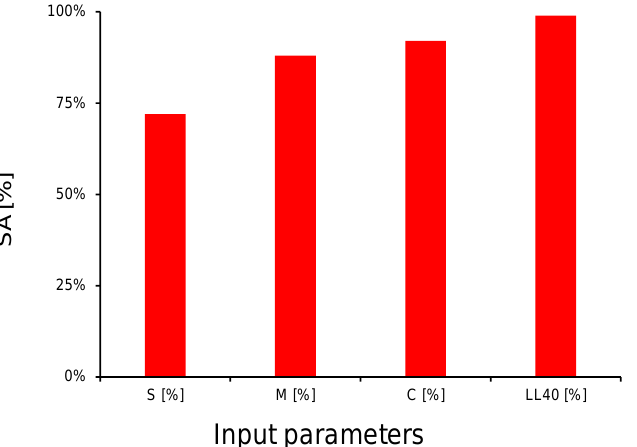
Figure 7. Sensitivity analysis of prediction model based on sensitivity of individual input parameters.